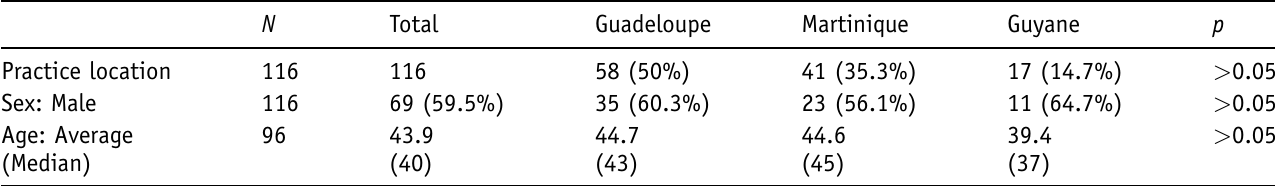
Table 1. Demographic data of dentists in Guadeloupe, Martinique and French